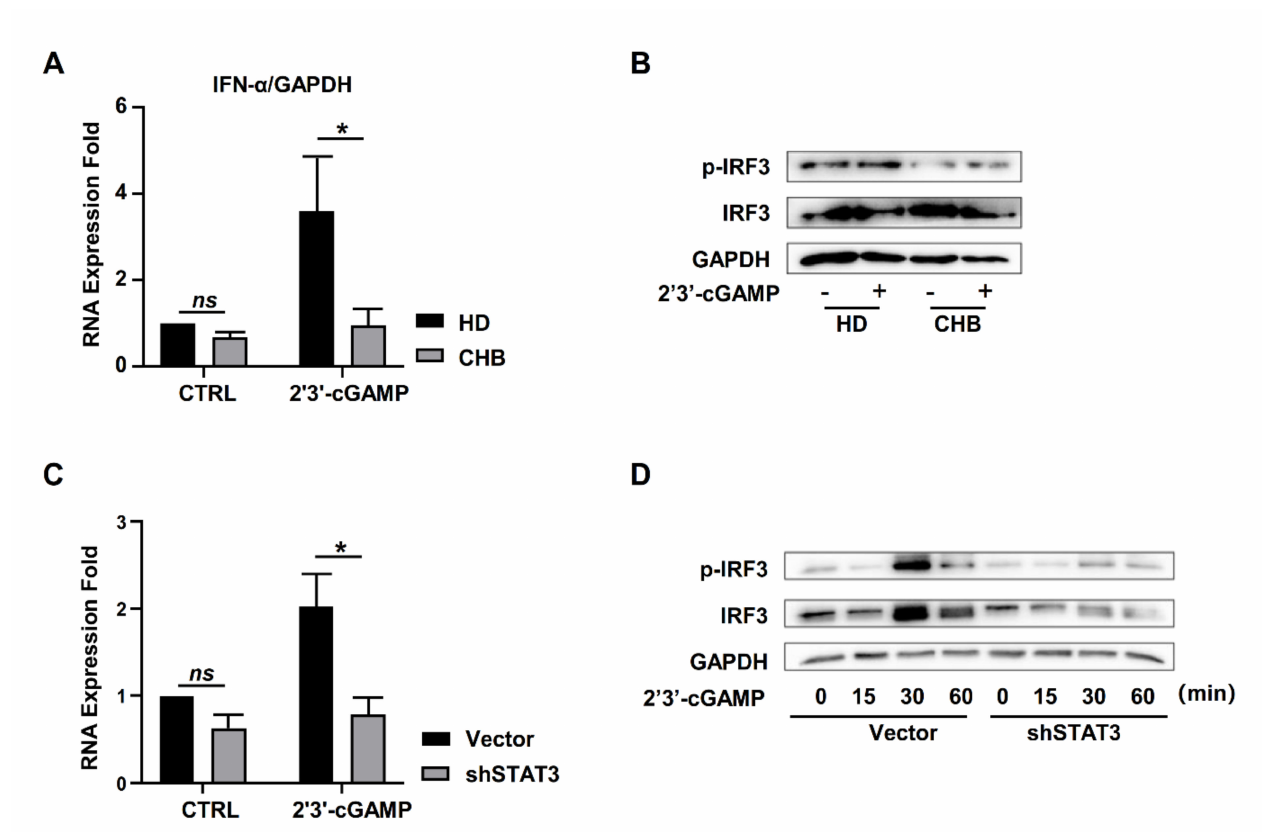
Figure 6. STING-associated IFN α response was inhibited in NK cells of HBeAg-negative CHB patients. ( A ) IFN α expression in NK cells isolated from HDs and CHB patients was quantified by qPCR after stimulation with 2 (cid:48) 3 (cid:48) -cGAMP (10 µ g/mL) for 12 h. ( B ) IRF3 and phosphorylated IRF3 in NK cells isolated from HDs and CHB patients were quantified by western blotting after stimulation with 2 (cid:48) 3 (cid:48) -cGAMP (10 µ g/mL) for 30 min. ( C ) IFN α expression in STAT3-knockdown NK-92 cells was quantified by qPCR after stimulation with 2 (cid:48) 3 (cid:48) -cGAMP (10 µ g/mL) for 12 h. ( D ) IRF3 and phosphorylated IRF3 in STAT3-knockdown NK-92 cells were quantified by western blotting after stimulation with 2 (cid:48) 3 (cid:48) -cGAMP (10 µ g/mL) for 15, 30 and 60 min. Data are shown as mean ± SEM from three independent experiments. The statistically significant difference between two groups was determined by a t -test. ns, p > 0.05; * p < 0.05. CHB, CHB patients; HD, healthy donors; Vector, LMP or pCDH; shSTAT3, STAT3-knockdown NK-92 cells; STAT3-over, STAT3-overexpression NK-92 cells; NK, natural